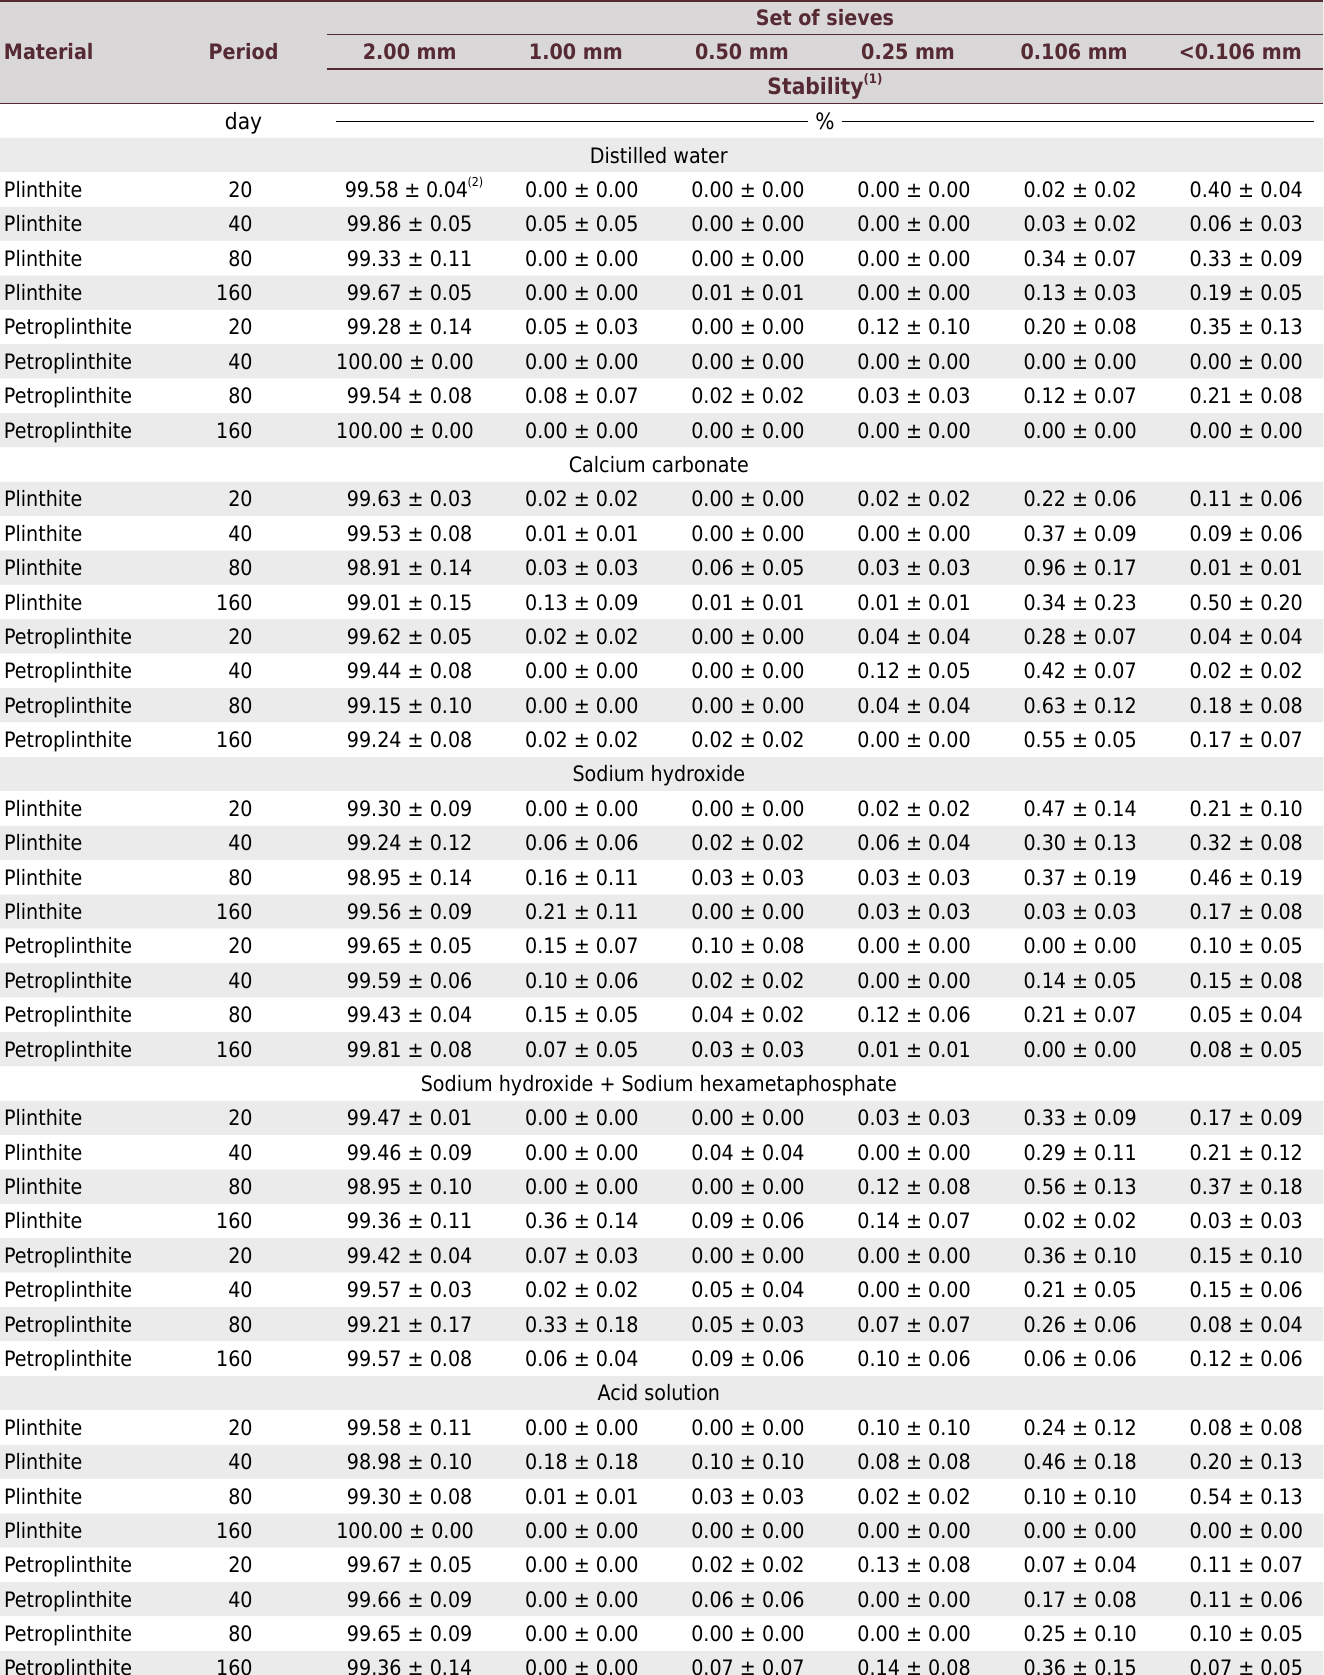
Table 7. Mean value and standard error of the mean stability of plinthite and petroplinthite of the profiles, immersed in different solutions for different periods